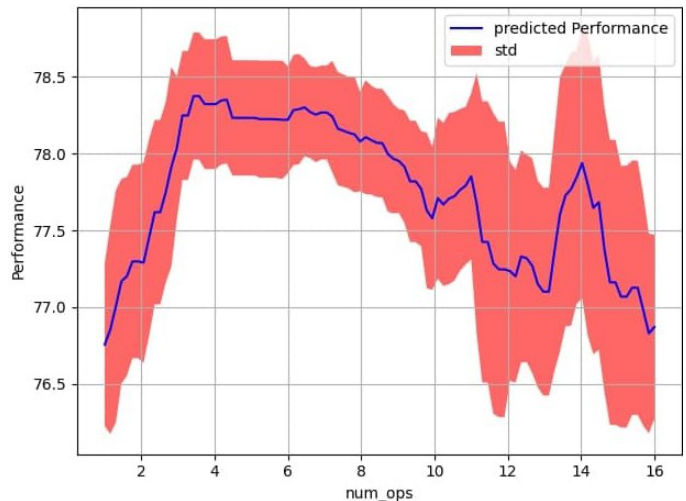
Figure 3. Performance (mean IoU) analysis for different numbers of operations for RandAugment++ on EM. These results indicate that the number of applied operations should optimally not be limited to three, as in classical RandAugment.